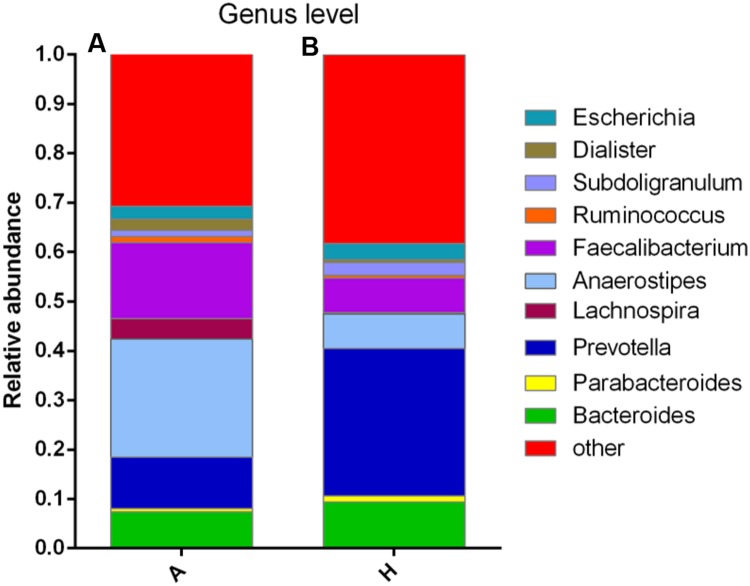
Composition and relative abundance of bacterial communities based 16S rDNA sequences in A and H groups. (A) Unsupervised hierarchical clustering analysis. (B) The relative abundances of the major bacteria in genus level.